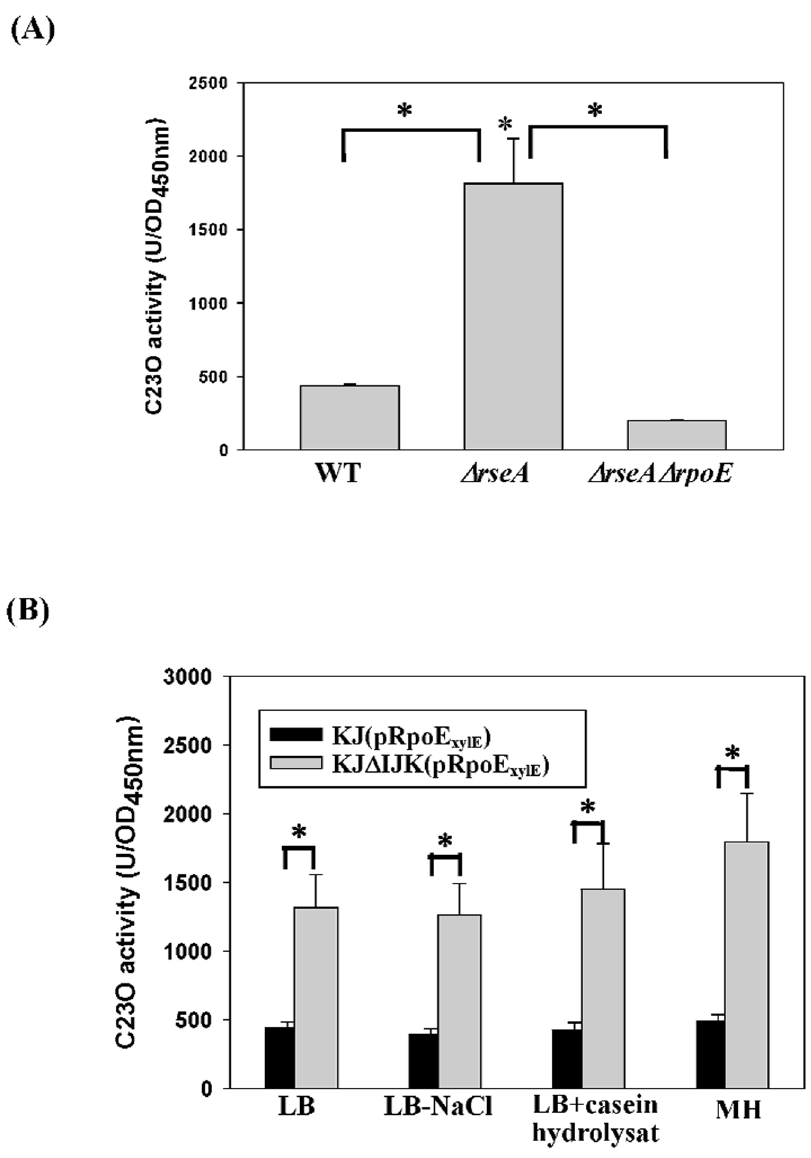
Figure 4. Determination of P rpoE activities in different strains and culture conditions. Plasmid containing a transcriptional fusion of the upstream region of rpoE to the xylE gene (pRpoE xylE ) was transferred into the wild-type KJ and its derived mutants. The C23O activities of the logarithmic-phase cultures of these strains were determined. Each bar represents the mean of three independent experiments. Error bars, where visible, indicate the average deviation. *, p # 0.01 significance calculated by a Student’s t -test. (A) The impacts of resA mutant and rseA/rpoE double mutant on the promoter activity of rpoE gene. (B) The impacts of smeIJK mutant and culture media on the promoter activity of rpoE gene.